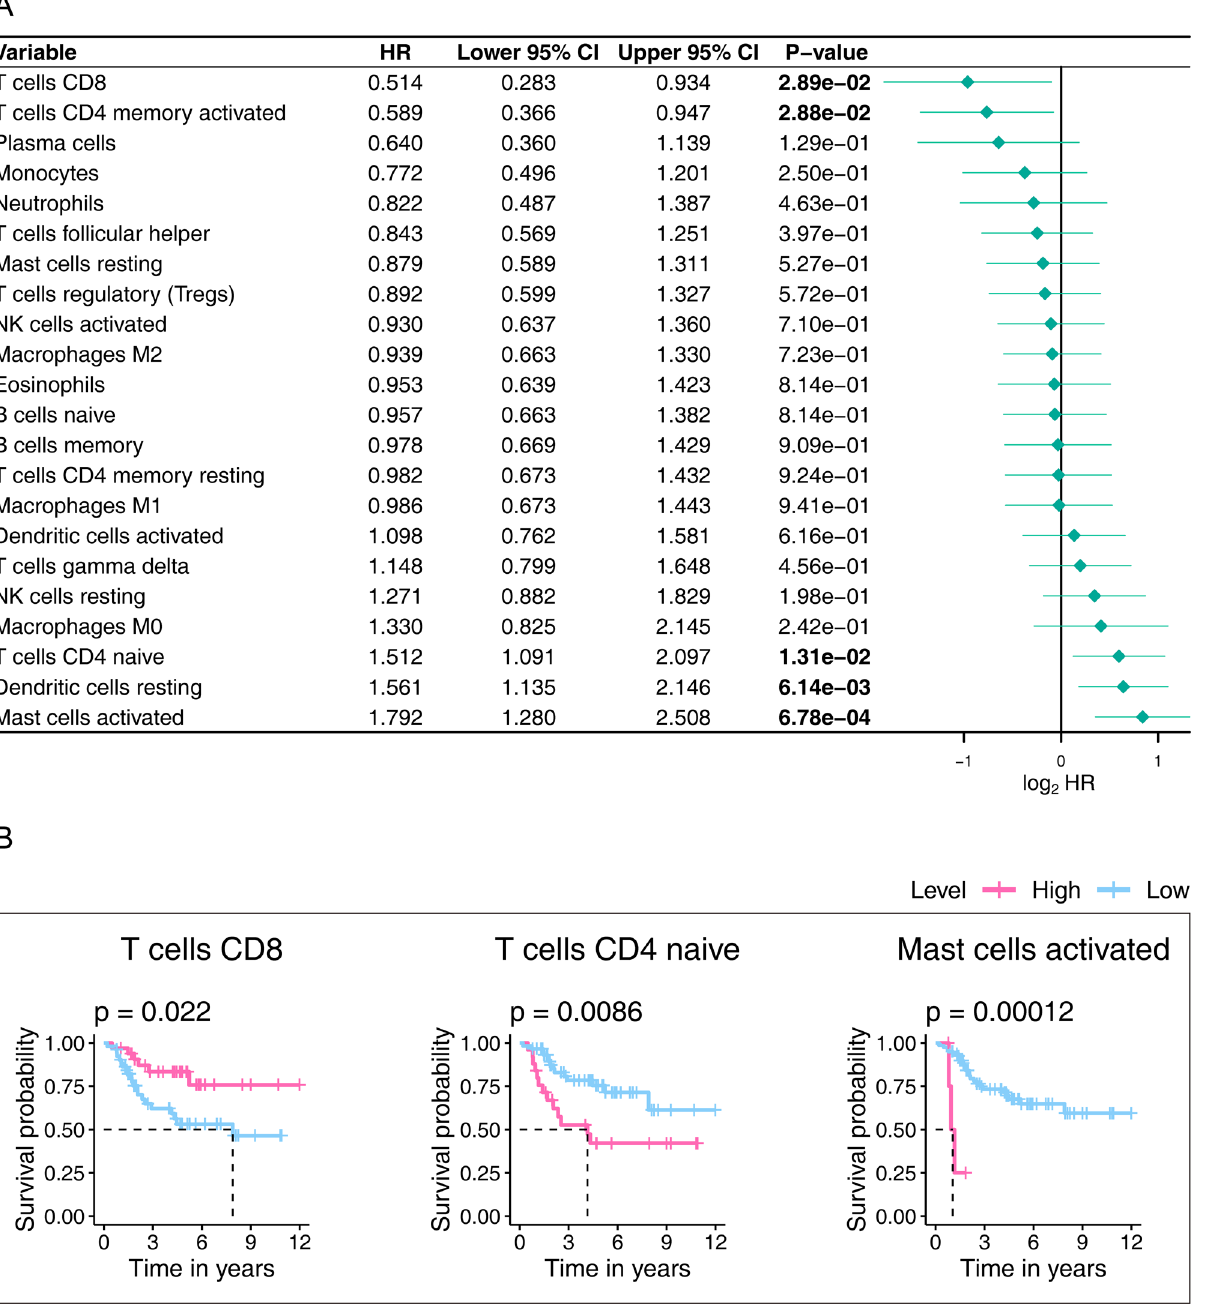
Figure 11. Univariate Cox proportional-hazards model ( A ) and Kaplan–Meier estimator ( B ) that built for evaluating the prognostic ability of 22 TICs. Only graphs with a p value < 0.05 in the log-rank test were plotted in ( B ). The bold p value indicates that < 0.05, which considers significant. TIC tumor-infiltrating immune